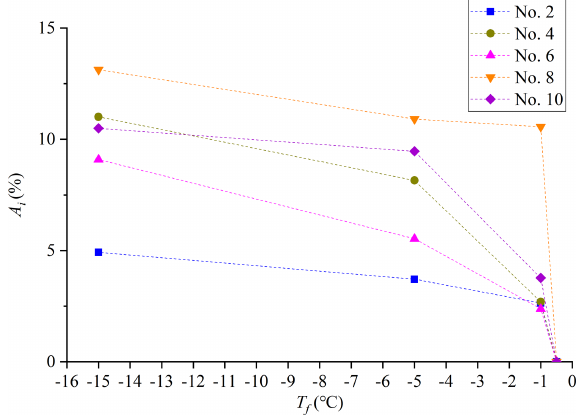
Figure 8. The aggregation area of rupture ice increases with the reduction in freezing temperature. Experimental conditions: v = 0.2mmmin − 1 , d = 2mm and σ n = 0.5MPa. A i : aggregation area percentage of rupture